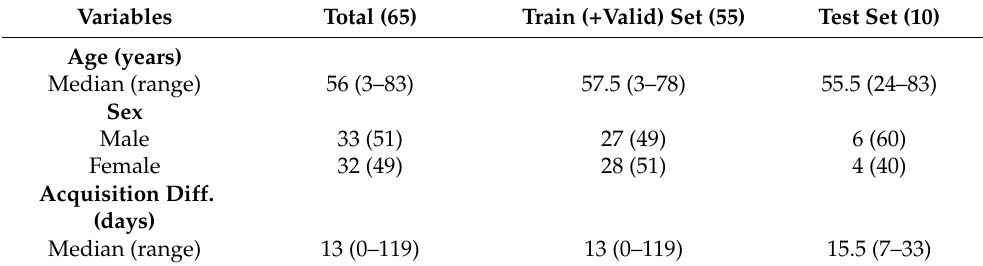
Table 1. Patient